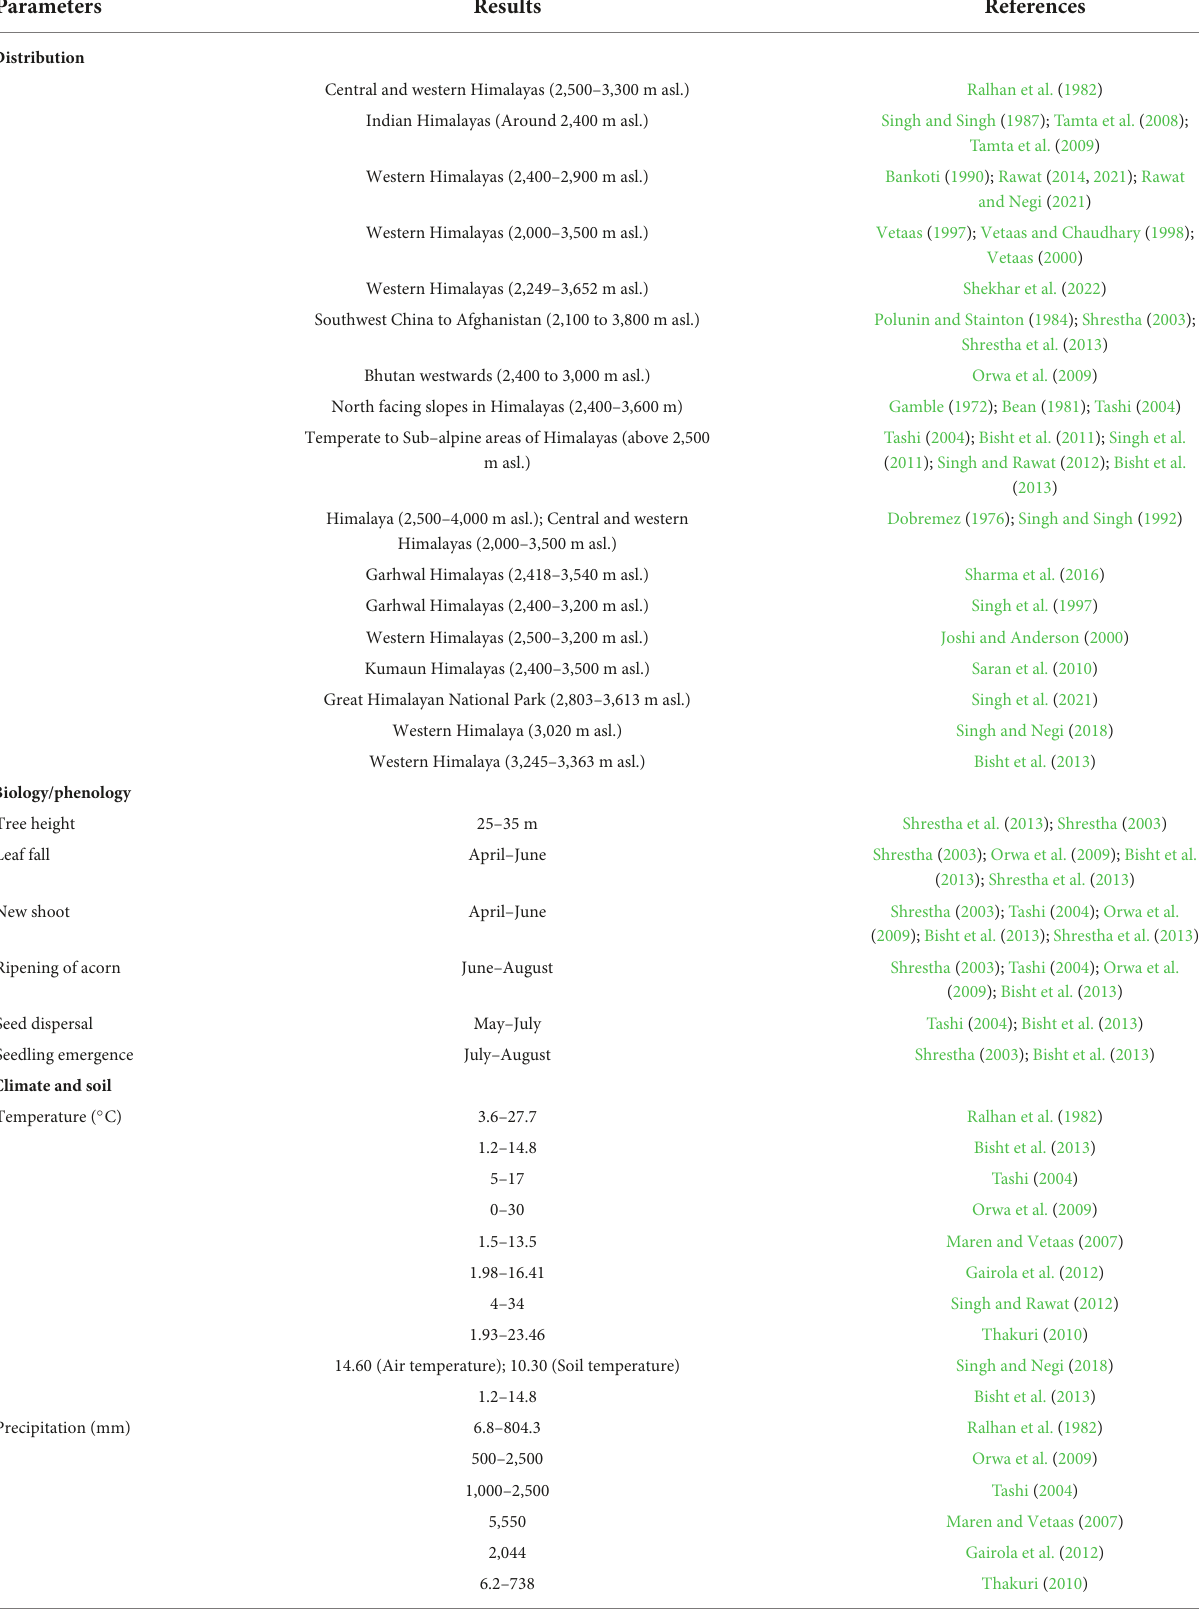
TABLE 1 Details of the distribution, phenology and climatic features of Q. semecarpifolia forests.